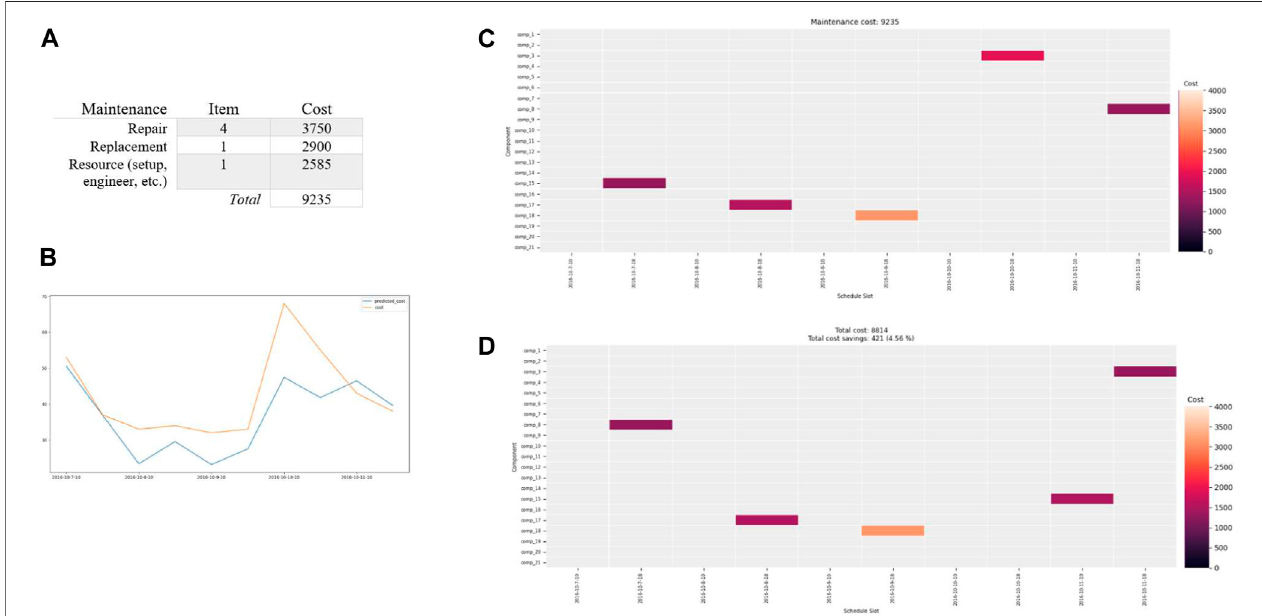
FIGURE11|(A) Theoverallmaintenancecostsincludingresourcesofengineerandsetupbasedoninputs,i.e.,allmaintenance988itemsforthe fi vemaintenance components over the fi ve-day period. (B) Overall predicted cost comparison between the optimized cost (i.e., d) and the actual cost (i.e., c) over the same period. Maintenance schedule with group maintenance over the fi ve-day period (C) without optimization and (D) with optimization over 4% cost-saving over the same parameters and period.